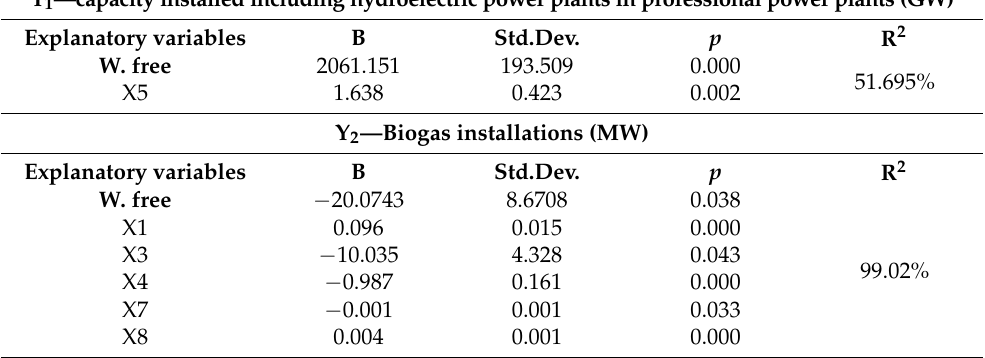
Table 7. Parameters of cause-and-effect models for variables Y 1 , Y 2 , Y 3 , Y 4 , Y 5 , Y 7